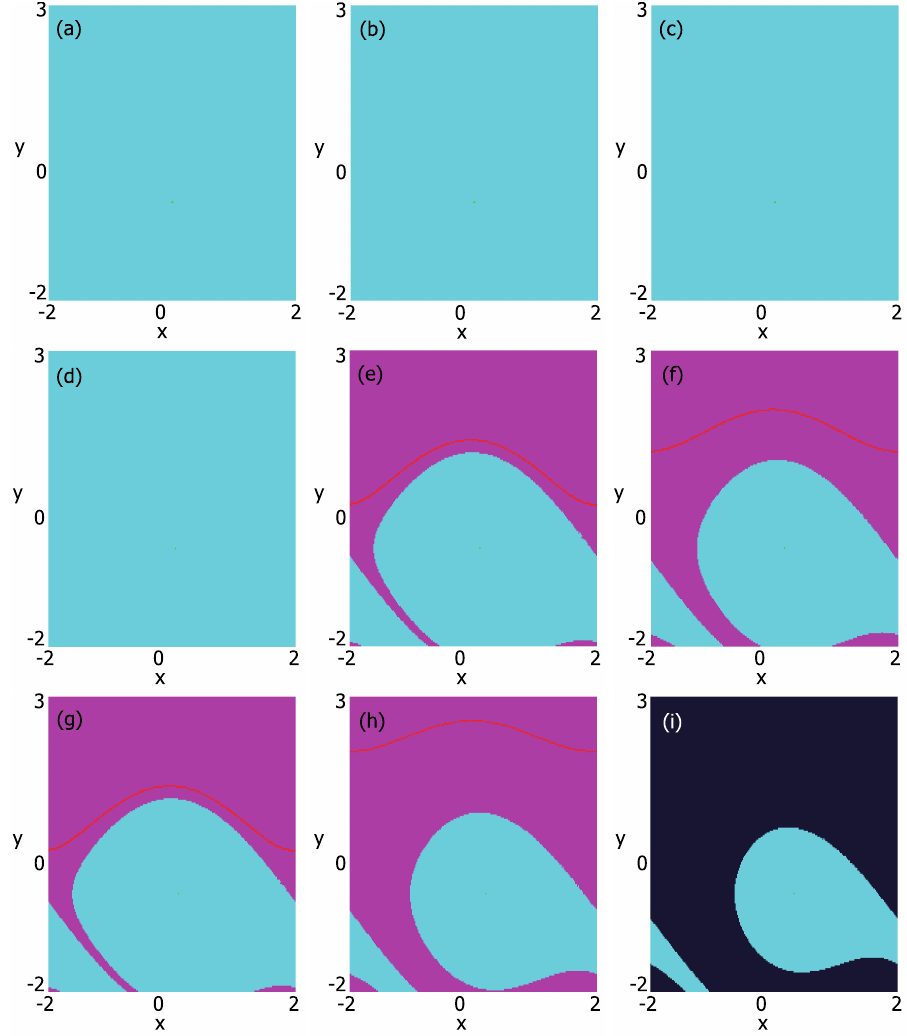
Figure 11. Plots of the basins of attraction of the vertically excited parametric pendulum with a torque. We use the parameters ω = 2, α = 0.1, γ = 0.1, γ = 0.2 and γ = 0.3, from left to right respectively, and vary ν = 0, ν = 0.2 and ν = 0.4, from top to bottom respectively. Each color represents a different basin. When the external torque varies, new attractors appear and the basin topology is modified, so that the motion can be transformed from periodic into chaotic or vice versa, as shown in ( a – i ).